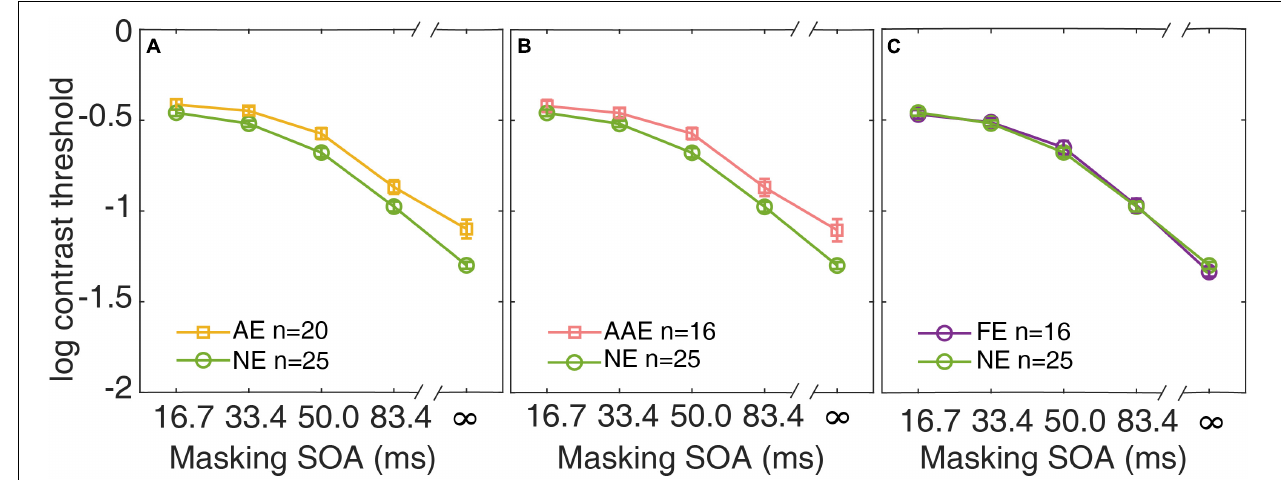
FIGURE 3 | Average contrast thresholds as a function of SOA are shown for the AE (A) , the AAE (B) , and the FE (C) . The average contrast thresholds of the NE are also plotted in each panel for comparison. Yellow: AE. Pink: AAE. Purple: FE. Green: NE. Error bars represent ± 1 standard error.